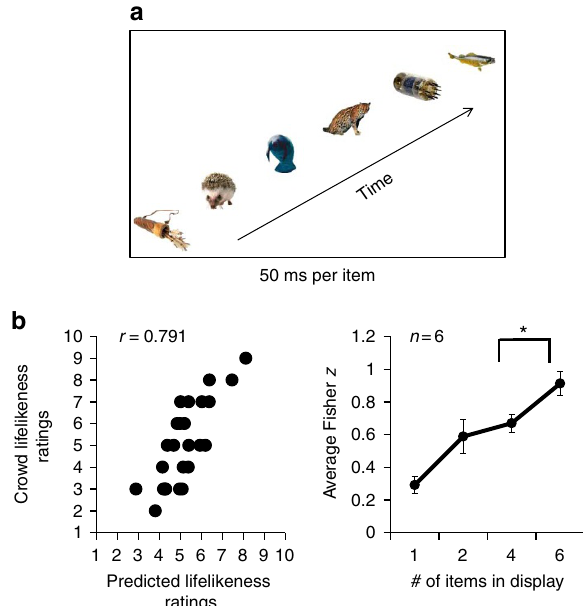
Figure 6 | Example stimuli and results for Experiment 5. ( a ) In the whole set condition, participants viewed groups of six stimuli, sequentially presented for 50ms each. Participants then rated the average lifelikeness of the previously seen group. ( b ) Experiment 5 results. Left: Crowd lifelikeness of temporally presented groups is well predicted by the average of individual item ratings. This graph depicts the ratings (black circles) of one representative participant who judged 25 unique temporal crowds in the whole set condition. There is a high correlation between the ratings of average crowd lifelikeness ( y axis) and predicted ratings of the crowds generated from single-item ratings ( x axis), n ¼ 25. Right: Average results for six observers. The x axis represents the number of items displayed in the set. The y axis represents the magnitude of the Fisher z score. The Fisher z score in the whole set condition indicates that participants were able to perceive ensemble lifelikeness in sequentially presented groups of items. Moreover, Fisher z scores increase as the number of items displayed increases. This pattern rules out the possibility that participants engaged in random subsampling to accomplish the task. Error bars represent